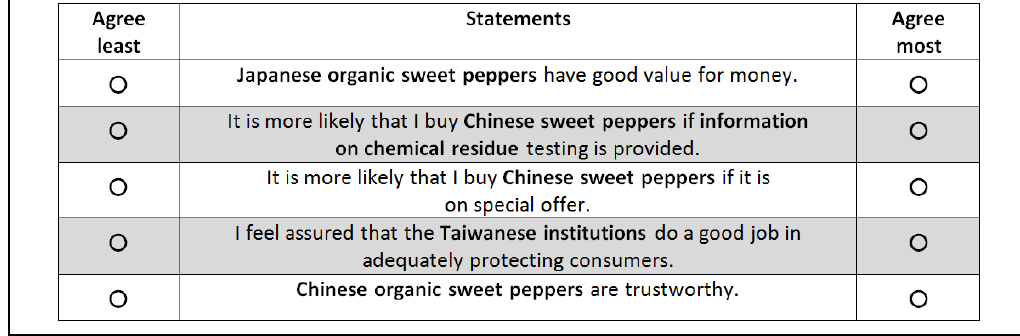
Figure 2. A choice task example of BWS (English translation).